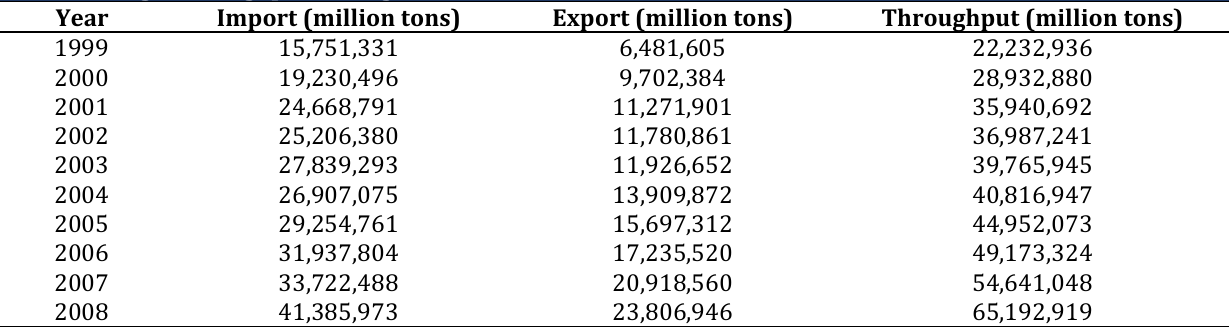
Table 2: Cargo Throughput during Pre-concession and Post-concession Era Year Import (million tons) Export (million tons) Throughput (million